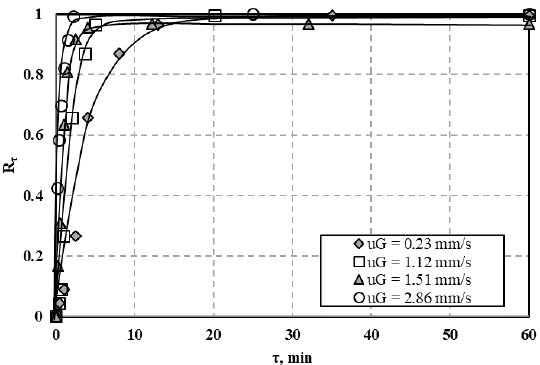
Figure A25. Changes in Al(III) temporary removal ratio during precipitate flotation from solution containing Al(III), Cu(II), and Zn(II) mixture—effect of air velocity (c 0 = 2 mmol dm − 3 , pH = 8.7, c SDS = 0.187 mmol dm − 3 ).